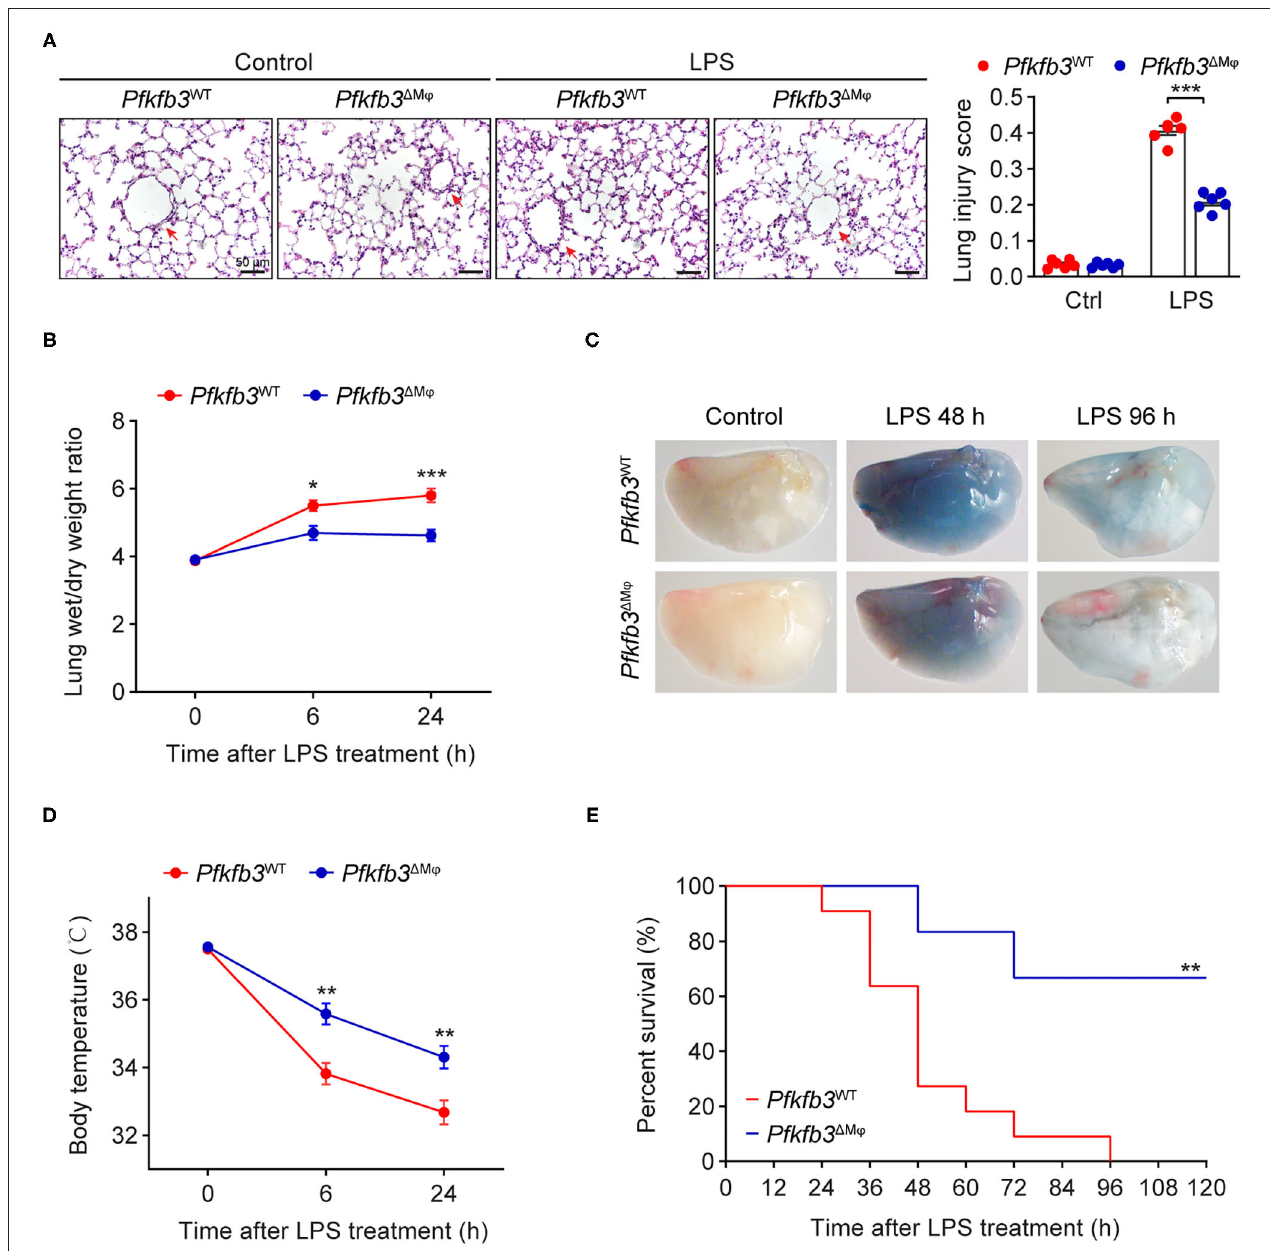
FIGURE 4 | Myeloid-specific Pfkfb3 deficiency protects mice from LPS-induced acute lung injury. (A) Representative images of hematoxylin and eosin staining (left) and lung injury score analysis (right) of lung sections from Pfkfb3 WT mice and Pfkfb3 1 M φ mice 6h after LPS injection ( n = 6). (B) The wet/dry weight ratio of lung tissue of Pfkfb3 WT mice and Pfkfb3 1 M φ mice after LPS injection ( n = 6-8). (C) Representative images of Evans Blue staining of lung tissue of Pfkfb3 WT mice and Pfkfb3 1 M φ mice after LPS injection. (D) Changes of body temperature of Pfkfb3 WT mice and Pfkfb3 1 M φ mice after LPS injection ( n = 9). (E) Survival curve of Pfkfb3 WT mice and Pfkfb3 1 M φ mice following LPS injection ( n = 6–11). All data are represented as mean ± SEM, * P < 0.05, ** P < 0.01 and *** P < 0.001 for indicated comparisons. Unpaired two-tailed Student’s t test for (B,D) and Mantel-Cox test for (E)